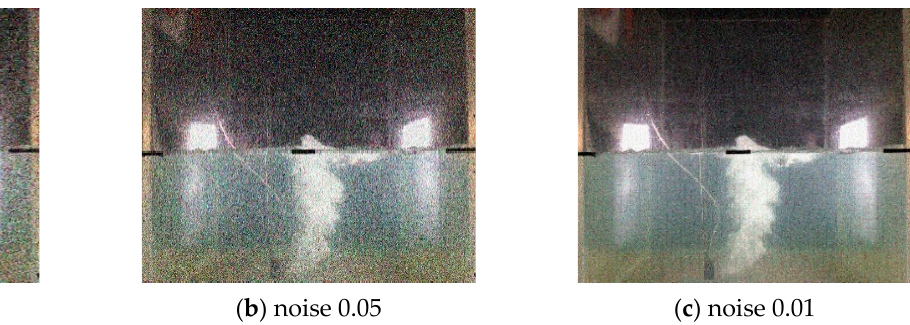
Figure 7. Images of underwater gas plumes under Gaussian noise with intensities 0.01, 0.05, and 0.1.